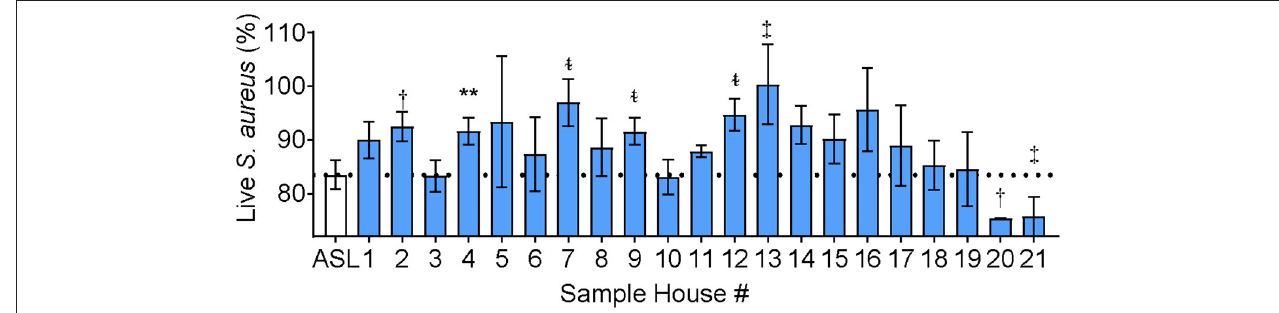
FIGURE 4 | ASL antimicrobial activity in presence of Iowa house IAP. Percent live bacteria after treatment with ASL control (dotted line), and percent live bacteria after ASL was treated with indoor samples from all study participants. Error bars represent means and standard error of the means. IAP from house #4 significantly inhibited S. aureus bacterial killing, while IAP from five houses resulted in a trend of inhibited S. aureus killing, and two houses had a trend of enhanced S. aureus killing, ( p ≤ 0.18). To test for differences between each house’s IAP and ASL with the field-blank (filter) control, percent live bacteria after treatment with ASL control was compared using paired t -tests to the percentage of live bacteria remaining after ASL was treated with each participants’ IAP, ** p < 0.01, † p = 0.06–0.10, ‡ p = 0.11–0.15, and t ∼ p = 0.16–0.20.